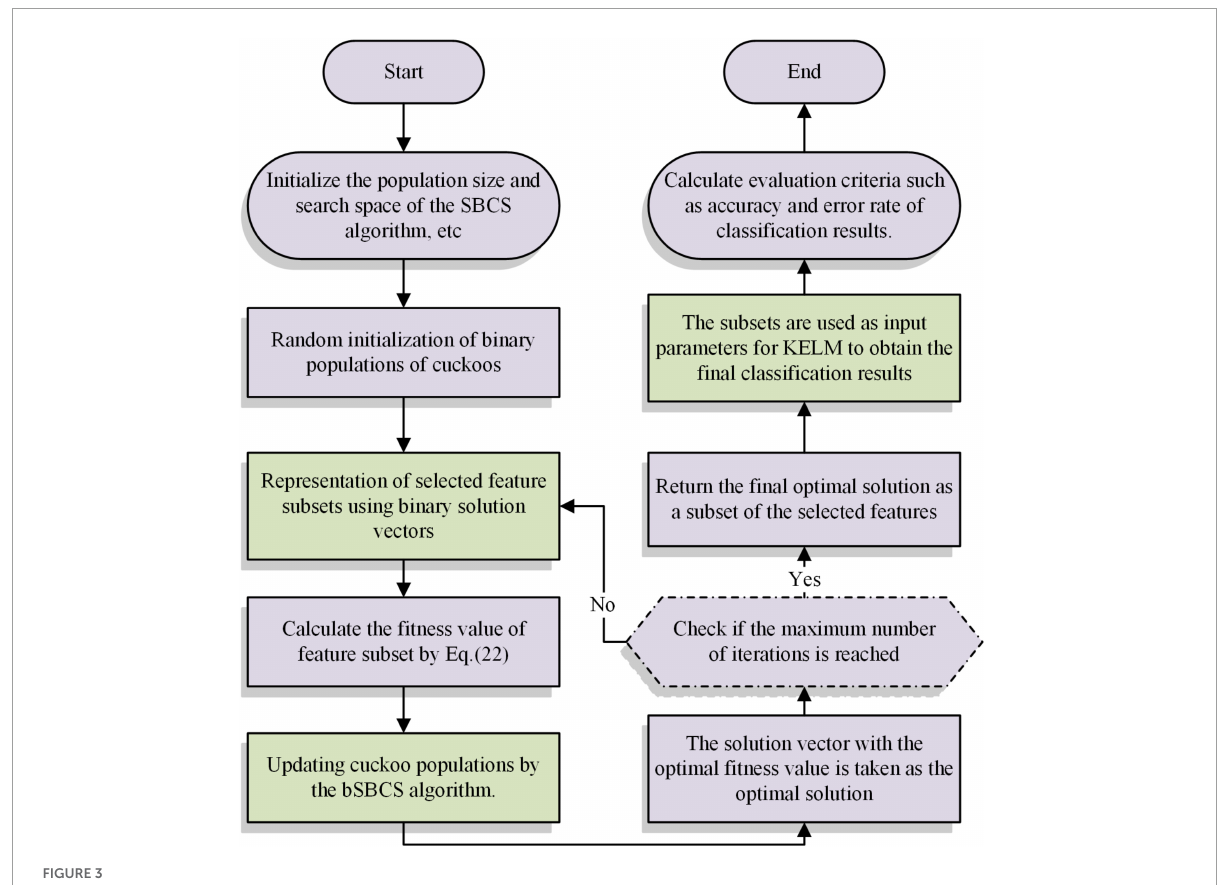
FIGURE3 Flow chart of bSBCS-KEML model.